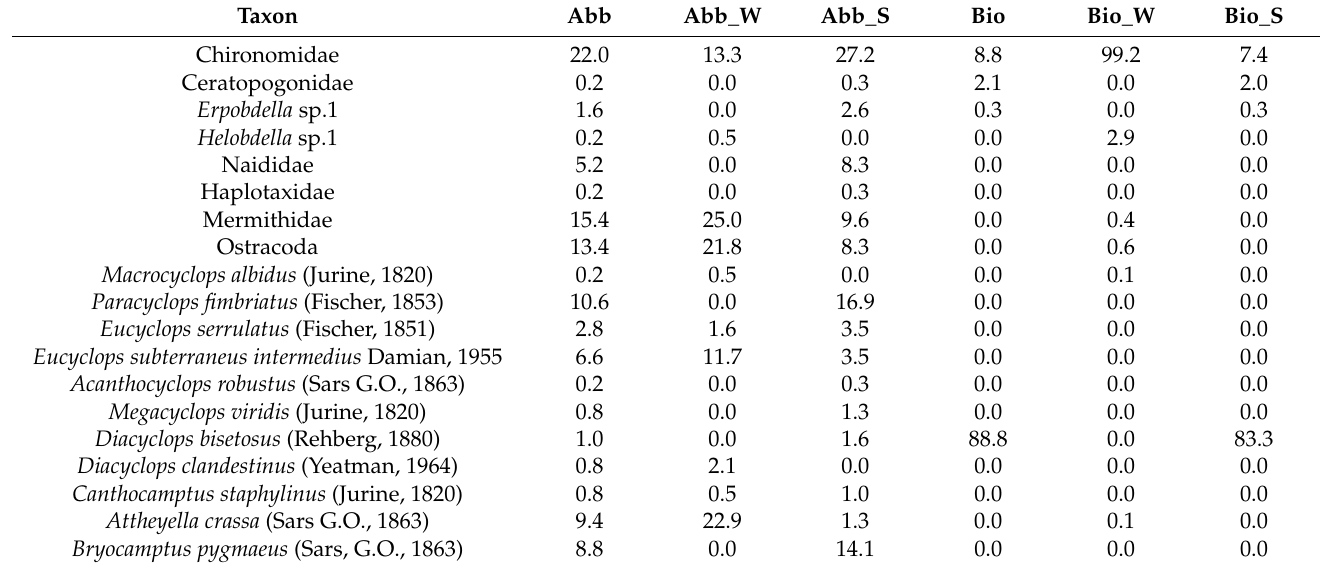
Table 2. Percentages of abundance (Abb) and biomass (Bio) of the taxa collected in the downstream stretch of the Rio Gamberale. Percentage data are also reported according to the season: winter (December 2014: W) and summer (June 2015: